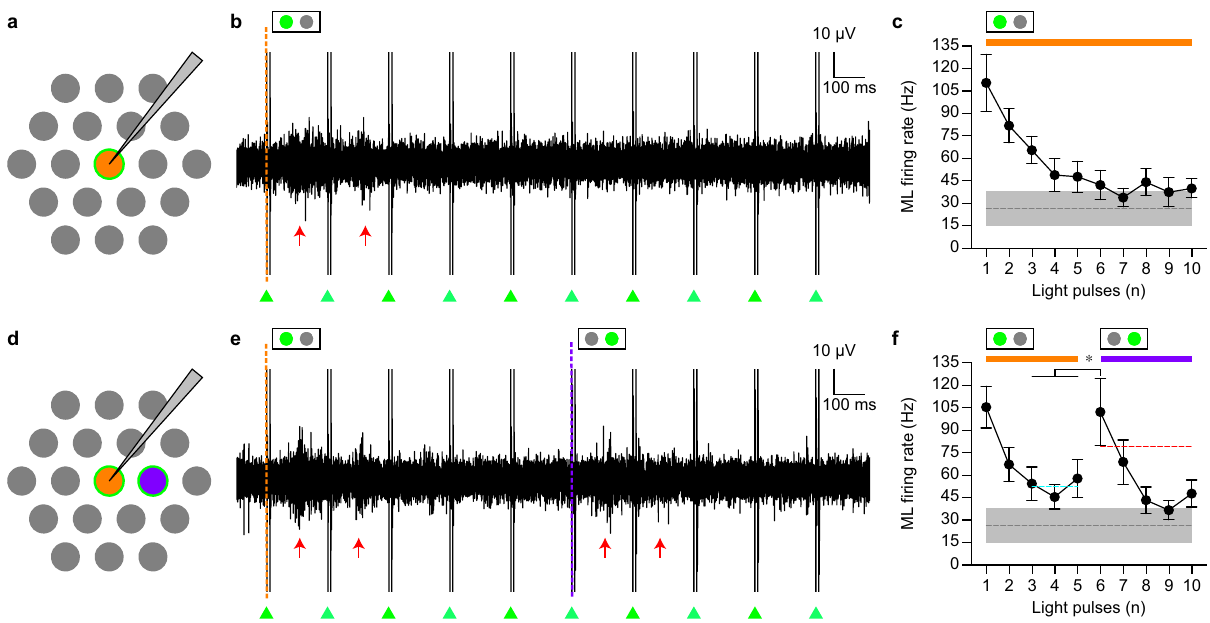
Fig. 6 Two-point discrimination pattern reversal test with single-pixel stimulation. a Sketch of the single-pixel repeated stimulation paradigm. One pixel was repeatedly illuminated at 5 Hz (560 nm, 10 ms, 0.9 mW mm − 2 ) for 2 s. b Raw electrophysiological recordings of a single RGC under 5 Hz continuous stimulation from a single pixel. The green triangles correspond to the onset of each pulse. The red arrows highlight the ML activity. c Quanti fi cation of the ML fi ring rate (mean ± s.e.m.) under continuous stimulation from a single pixel ( n = 12 RGCs). The grey dashed line is the average resting fi ring rate with its s.d. represented by the grey area. d Sketch of the two-point discrimination pattern reversal paradigm. The central (orange) pixel was repeatedly illuminated for 1 s at 5 Hz (560 nm, 10 ms, 0.9 mW mm − 2 ), then the illumination was switched to the adjacent pixel (purple) for 1 s at 5 Hz (560 nm, 10 ms, 0.9 mW mm − 2 ). e Raw electrophysiological recordings of a single RGC under 5 Hz two-point discrimination pattern reversal paradigm. The green triangles correspond to the onset of each light pulse. The pixel switch is highlighted by the purple dashed line. The red arrows highlight ML activity. f Quanti fi cation of the ML fi ring rate (mean ± s.e.m.) under the two-point discrimination pattern reversal paradigm ( n = 12 RGCs). The cyan dashed line is the average desensitised ML fi ring rate and the red dashed line is the recovery threshold. The grey dashed line is the average resting fi ring rate with its s.d. represented by the grey